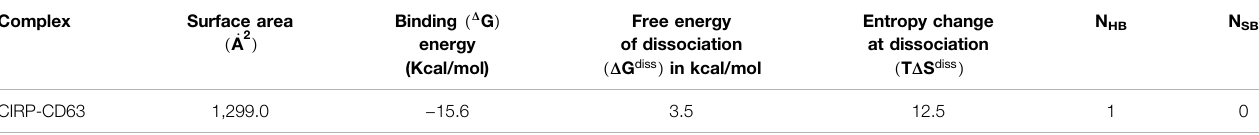
TABLE 1 | Interaction between CIRP and CD63 as revealed by computational analysis. The analysis of CIRP-CD63 complex interactions were calculated using PDBePISA tool. The surface area of interaction interface and thermodynamic parameters were determined.